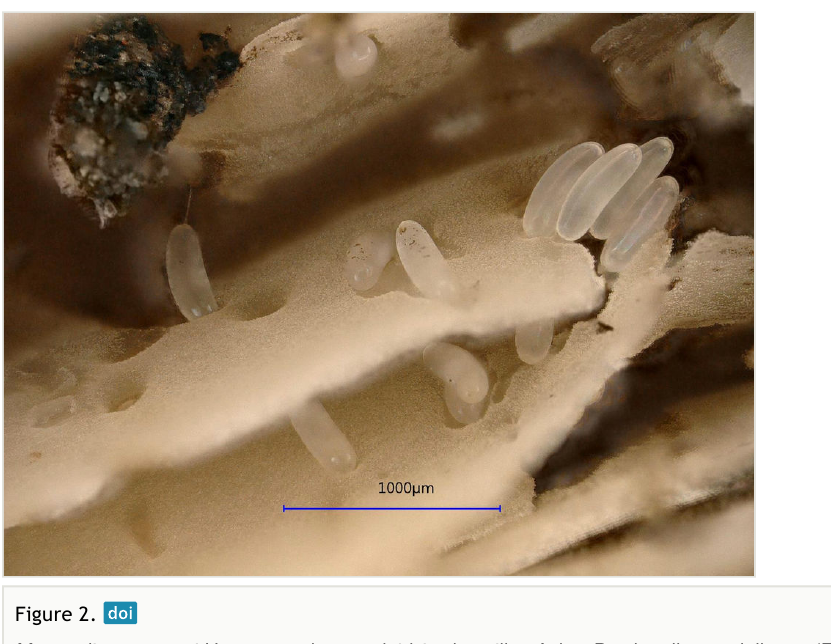
Megaselia marquezi Hartop et al. eggs laid in the gills of the Psathyrella candolleana (Fr.)